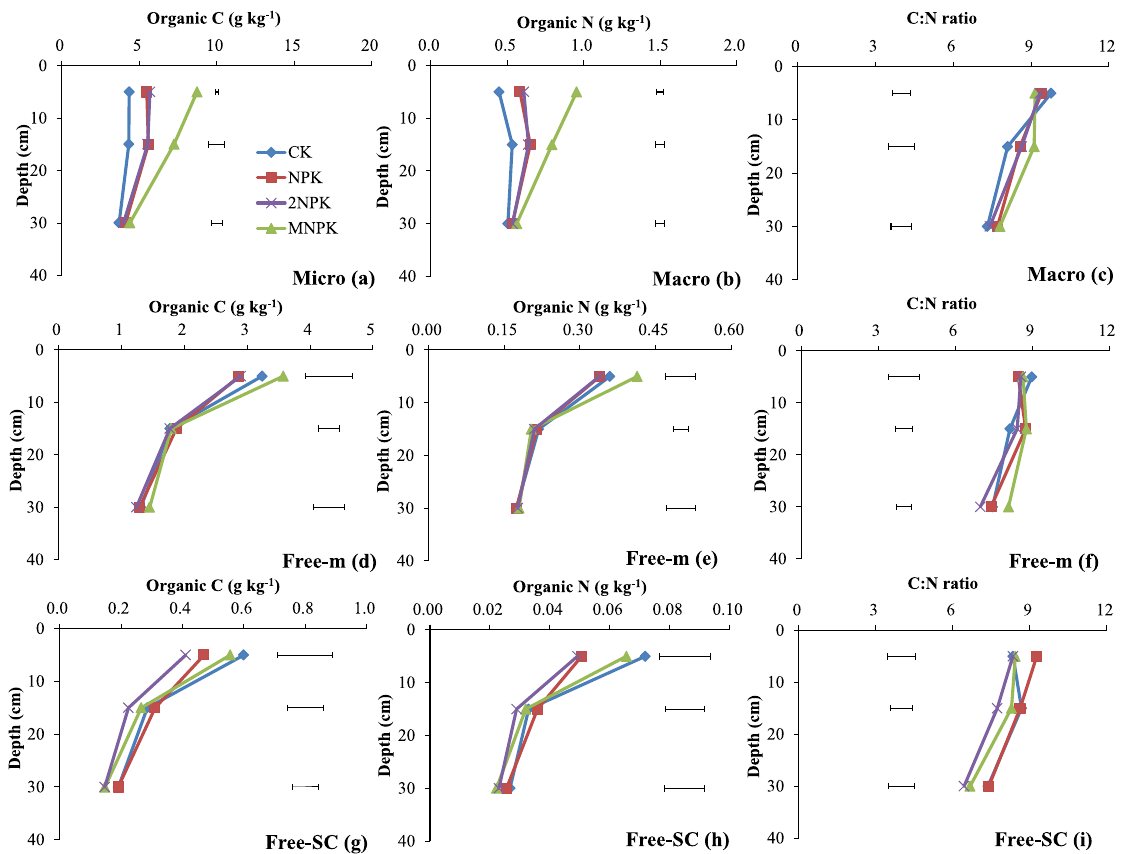
Figure 2. Organic C and N concentrations and C/N ratios of the water-stable aggregate fractions to 40 cm deep in the control treatment (CK), chemical fertilizer treatments (NPK and 2NPK), and combined manure and chemical fertilizer treatment (MNPK). Each value is the mean of three replicates. The horizontal lines indicate the least significant difference values at the 0.05 level (LSD0.05) for the different treatments at the different depths. The abbreviations for aggregates of each size are shown in the footnote to Table